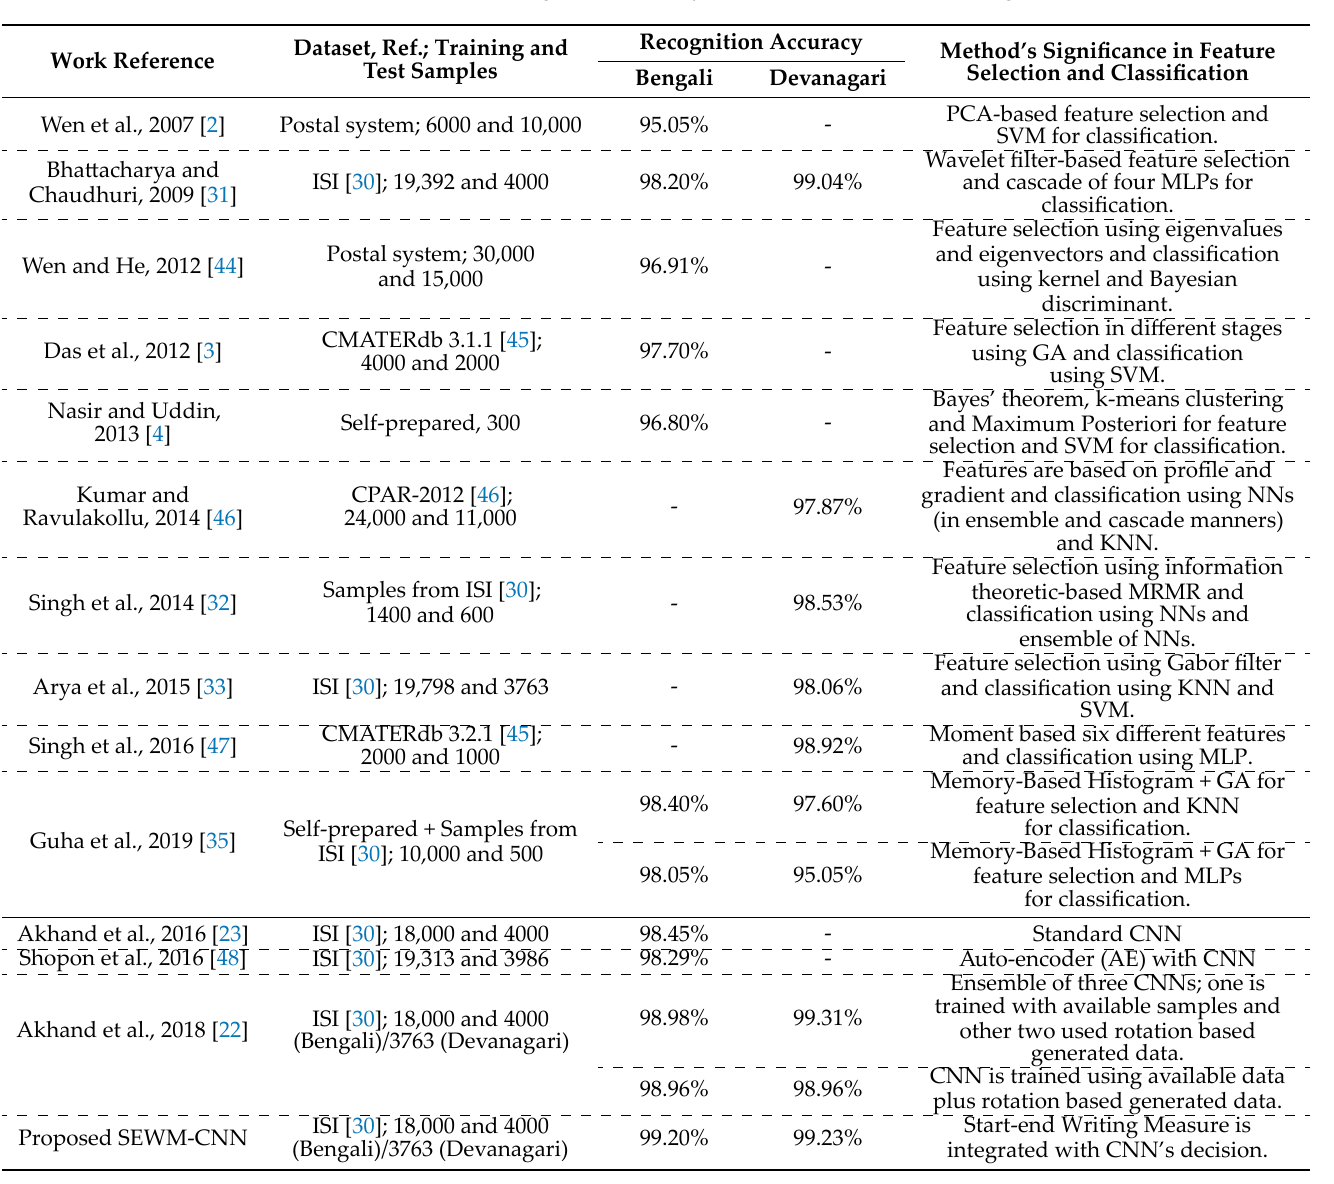
Table 5. Comparison of proposed SEWM‑CNN with prominent methods for Bengali and Devanagari HNR in terms of recognition accuracy, dataset used and method’s